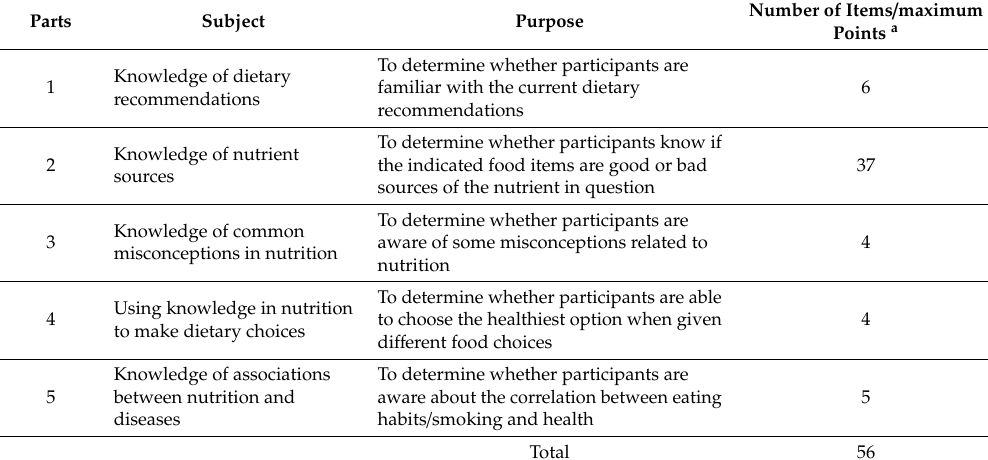
Table A1. Dietary Knowledge Questionnaire (DKQ) structure.